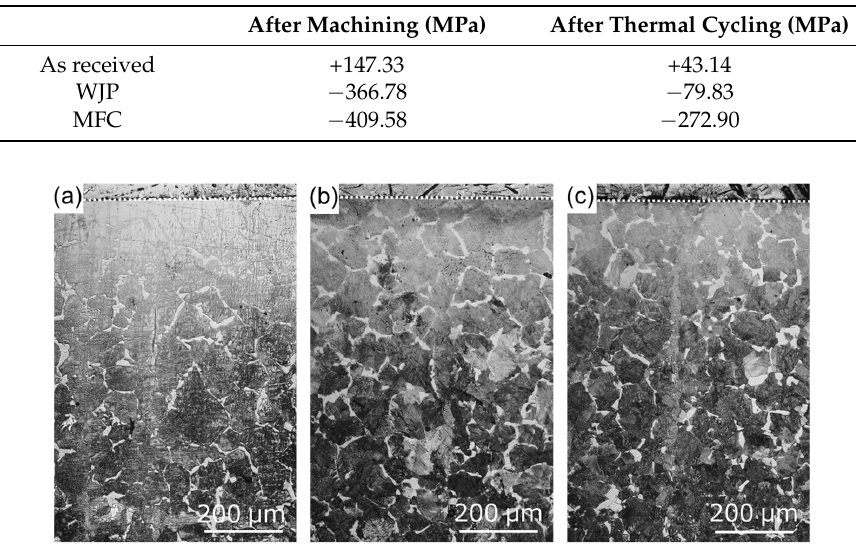
Figure 7. Cross-sectional OM images of ( a ) as-received specimen and specimens treated with ( b ) WJP and ( c ) MFC for 2 min after the thermal cycling test. The dashed lines indicate the surface of each specimen.